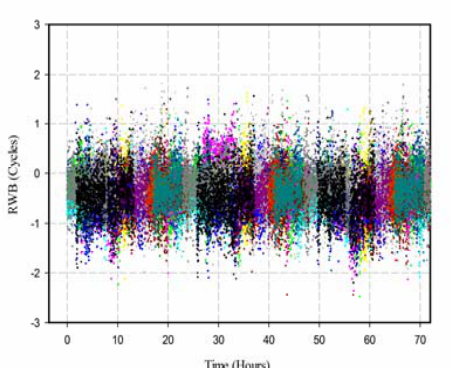
Figure 3. Three Days of RWB at ABMF IGS-MGEX Station